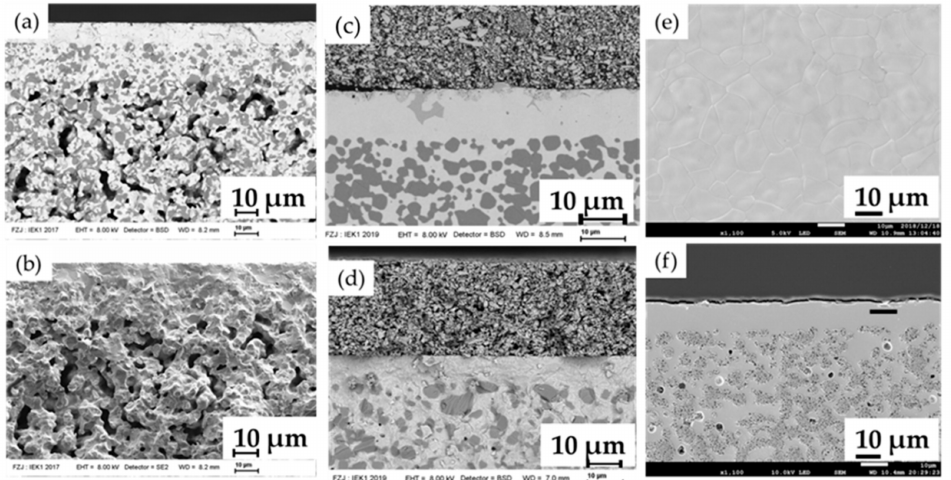
Figure 9. Scanning electron microscopy images of the as-fabricated BZCY(54) 8 / 9 2 electrolyte based cell. ( a ) BSD-SEM observation of a fracture cross-section of the BZCY(54) 8 / 9 2 / NiO-SZCY541 / NiO-BZCY(54) 8 / 9 2 half-cell. ( b ) Fracture cross-section of the NiO-BZCY(54) 8 / 9 2 / NiO-SZCY541 / BZCY(54) 8 / 9 2 half-cell. ( c , d ) The microstructure of a single cell composed of BLC electrode anode (half-cell sintered at 1450 and 1350 ◦ C respectively) ( e ) Typical surface view of the BZCY(54) 8 / 9 2 layer after sintering. ( f ) polished cross-section of a half-cell after NiO